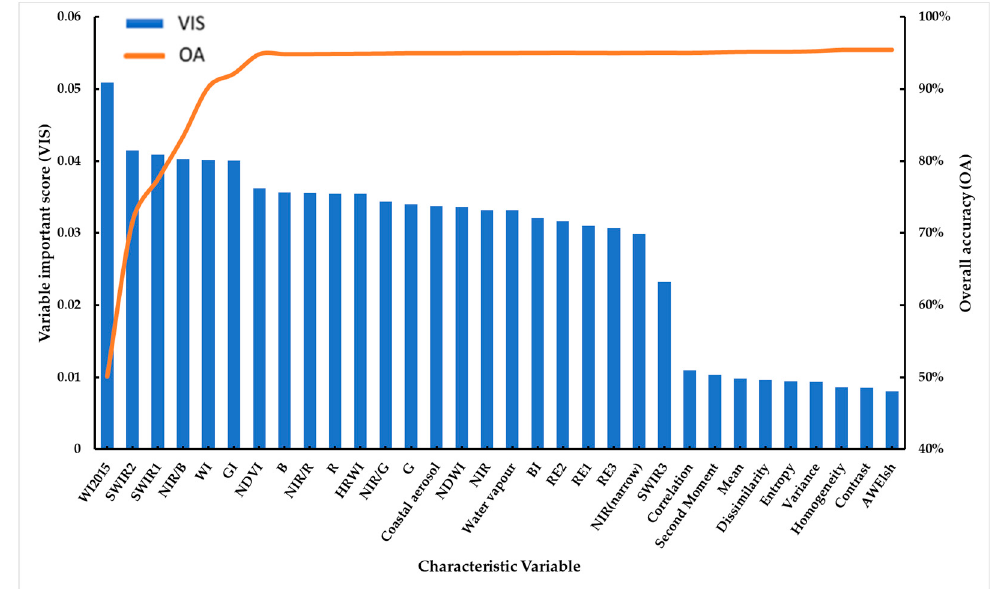
Figure 5. Changes to the VIS value and OA of each feature with the number of features. (Note: The reference image is a Sentinel-2 remote sensing image taken on 26 February 2020, with an orbit number of 132.)